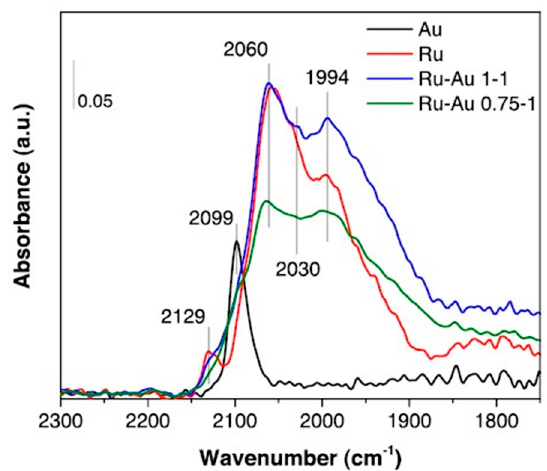
Figure 6. DRIFT (Di ff use Reflectance Infrared Fourier Transform Spectroscopy)-CO spectra of the mono- Figure 6. DRIFT (Diffuse Reflectance Infrared Fourier Transform Spectroscopy)-CO spectra of the and bimetallic Ru-Au / TiO 2 samples at room temperature. Figure from [100]. Copyright 2017, mono- and bimetallic Ru-Au/TiO 2 samples at room temperature. Figure from [100]. Copyright 2017, Elsevier.